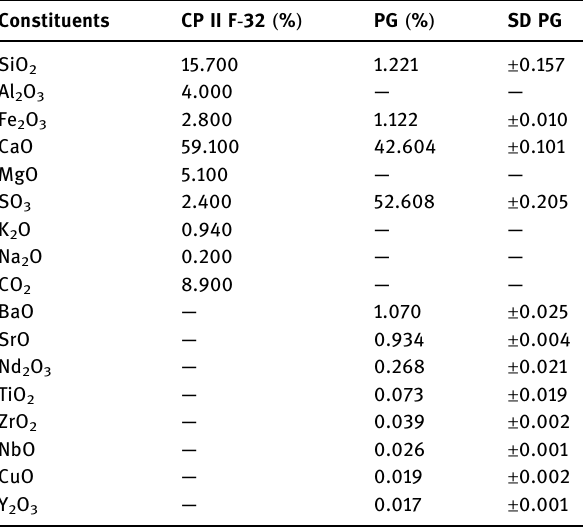
Table 1: Chemical composition of cement and PG